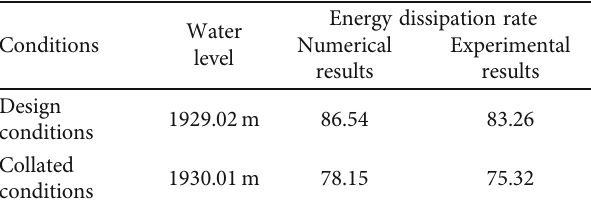
Table 4: The energy dissipation rate of the spillway.